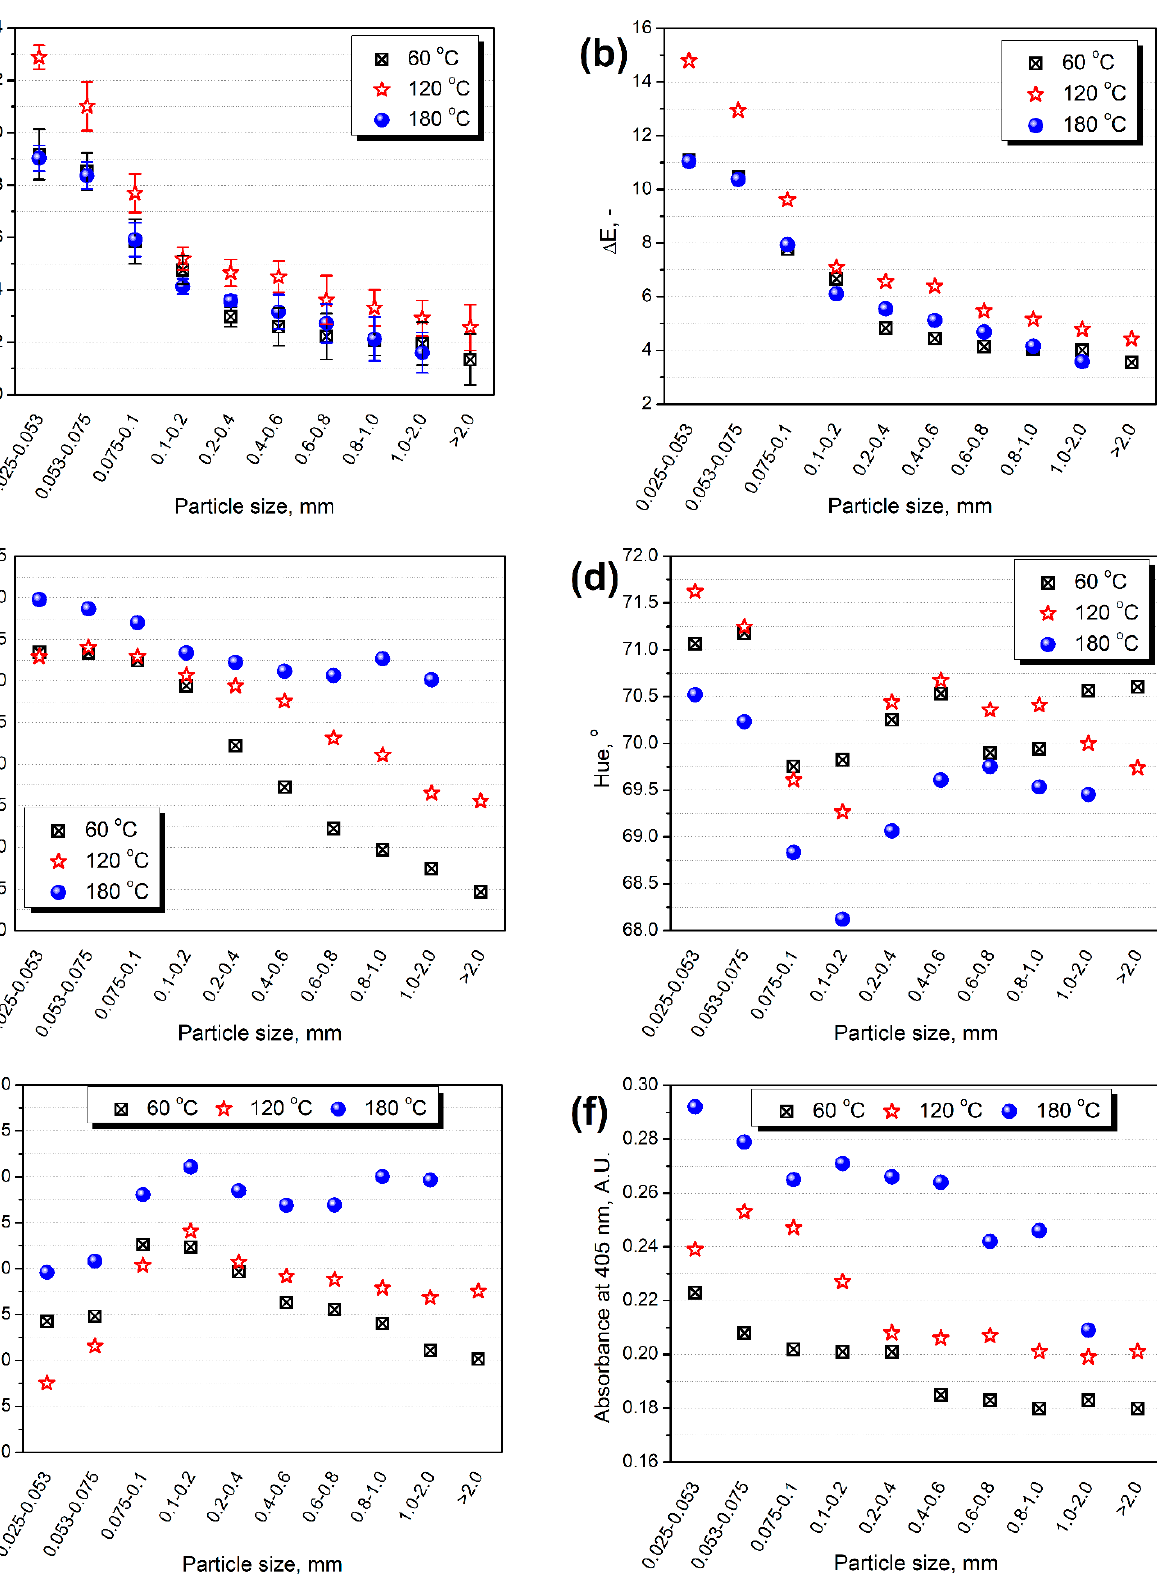
Figure 4. Plots of ( a ) lightness, ( b ) ∆ E parameter, ( c ) chroma, ( d ) hue, ( e ) browning index, and ( f ) absorbance at 405 nm as a function of particle size of BSG.